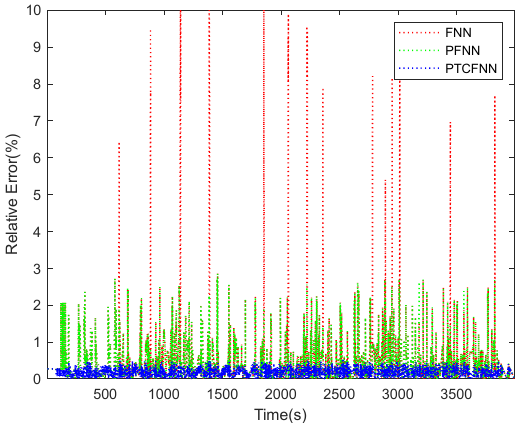
Figure 14. Relative error during dynamic current.